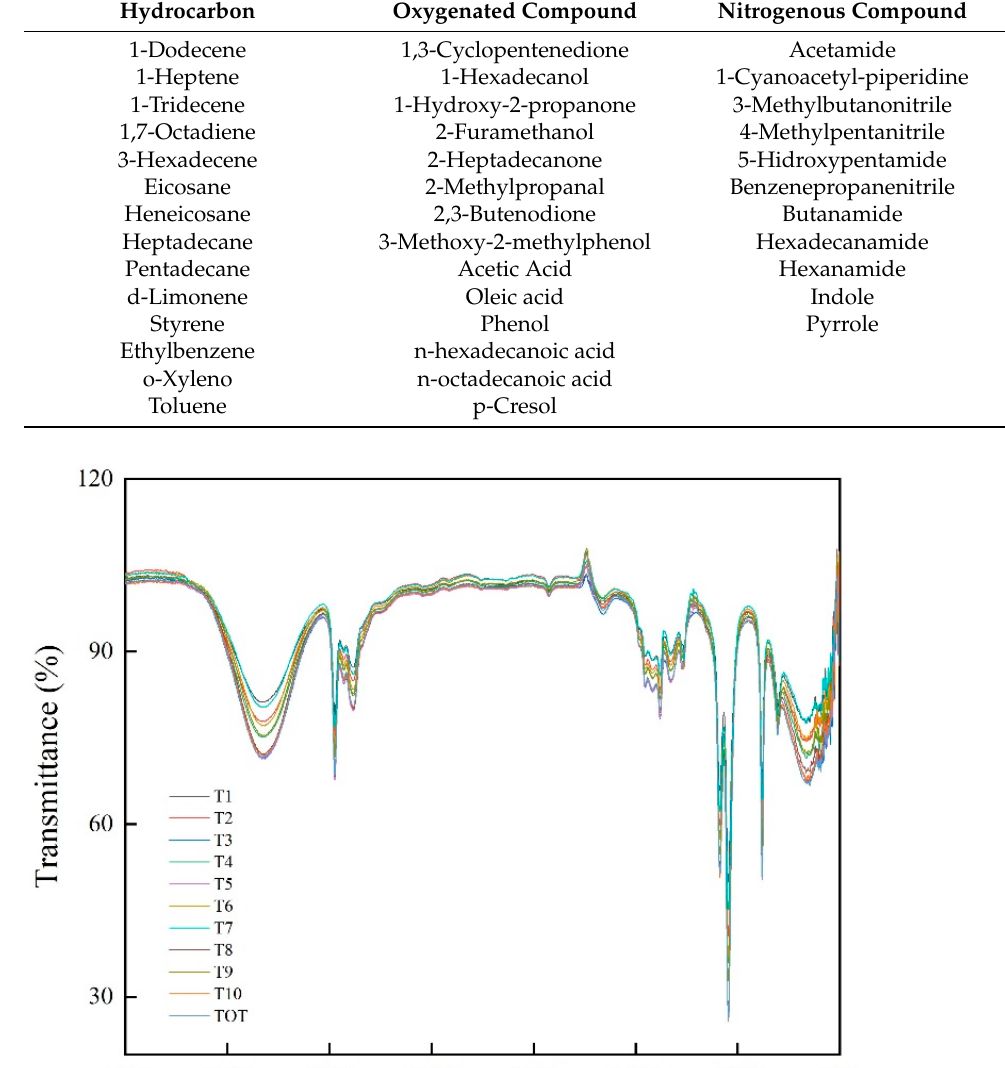
Table 6. Main compounds found in the bio-oil obtained by solar pyrolysis.